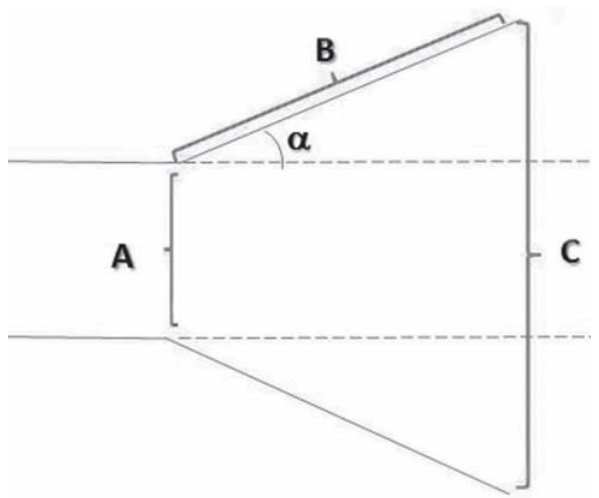
Fig. 9 - Diagrama esquemático do vaso aneurismático e suas medidas ultrassonográfico, importantes para determinação do ângulo aneurismático. a=ângulo de expansão do vaso. A: menor diâmetro do vaso; B: distância medida na parede do vaso compreendida entre seu diâmetro normal e sua maior